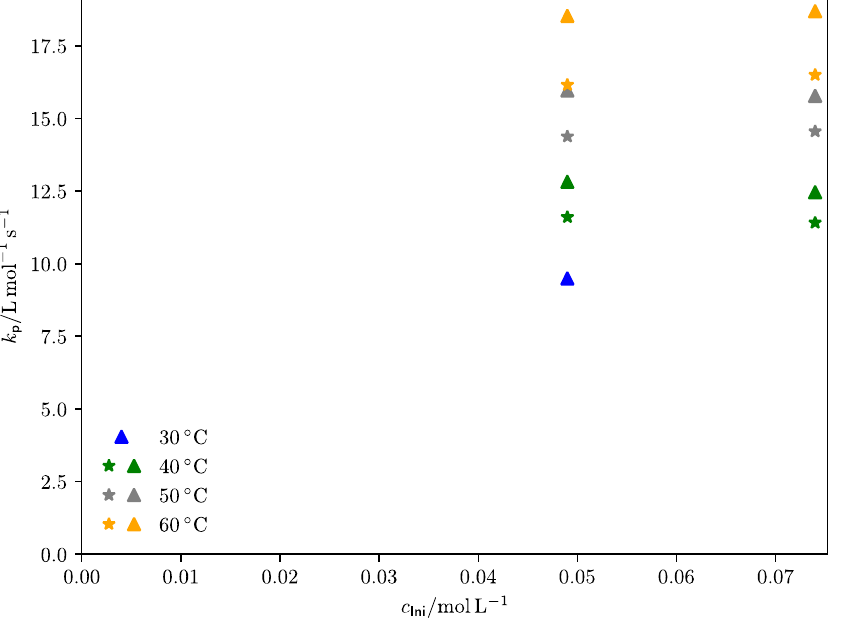
Figure 7. Arrhenius fit for 𝑘 (cid:2926) of DEI. The indicated uncertainties in ln( k p ) result from the standard deviation of the measurements for the respective temperature, while for the uncertainty in T − 1 an uncertainty of  T = 2K was assumed. For 30 °C, only one data point exists, consequently the uncer ‐ tainty in ln( k p ) was assumed to be similar to the other values. The obtained Arrhenius parameters are shown in Table 5. Table 5. Experimental Arrhenius parameters for chain ‐ length ‐ averaged k p of DnPI, obtained via PLP ‐ SEC.